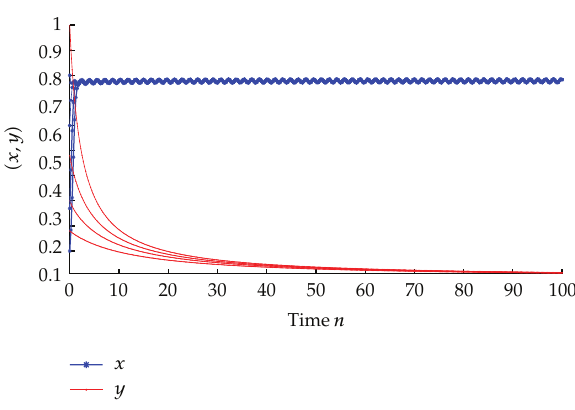
Figure 2: Dynamic behaviors of system (cid:6) 5.2 (cid:7) with the initial values (cid:6) 0 . 1 , 0 . 3 (cid:7) , (cid:6) 0 . 27 , 0 . 48 (cid:7) , (cid:6) 0 . 6 , 0 . 18 (cid:7) , and (cid:6) 0 . 8 , 1 . 0 (cid:7)